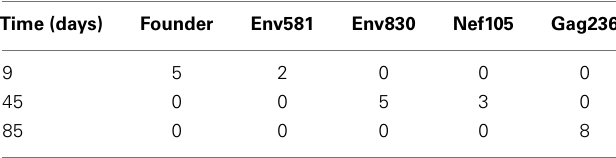
Table 1 | Format of input data: the escape mutations are ordered first by the time of first observation and then by